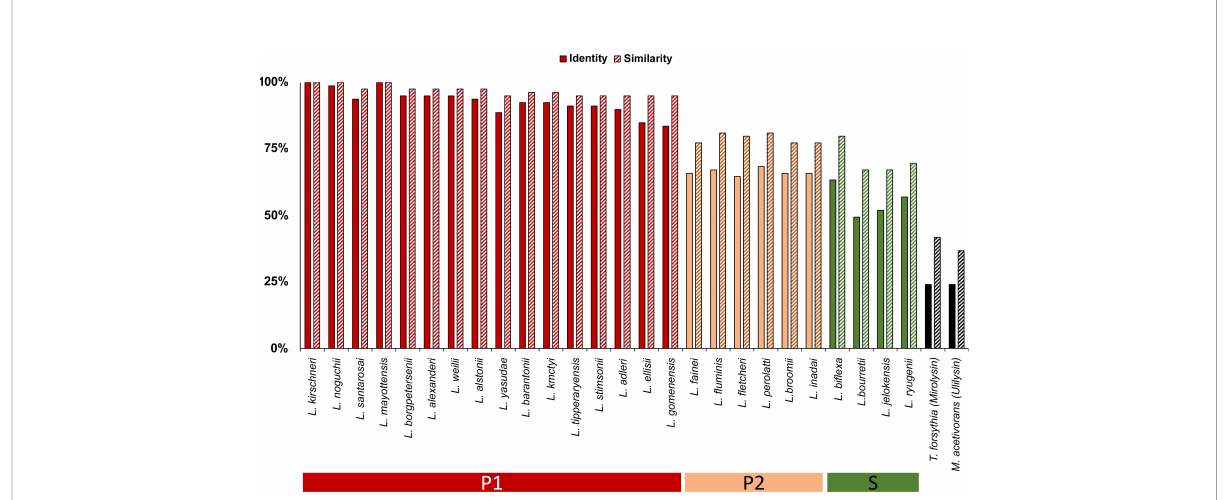
FIGURE 2 Conservation of leptolysin catalytic domain among Leptospira spp. Multiple sequence alignment of leptolysin catalytic domain was performed with MUSCLE software (Edgar, 2004), and included 17 Leptospira species of the subclade P1, 6 species of the subclade P2, 3 species of the subclade S1, and 1 species of the subclade S2. Mirolysin and ulilysin catalytic domains were also included. Leptolysin sequence similarities of all species are presented as a percentage value relative to the protein sequence of L. interrogans serovar Copenhageni L1-130